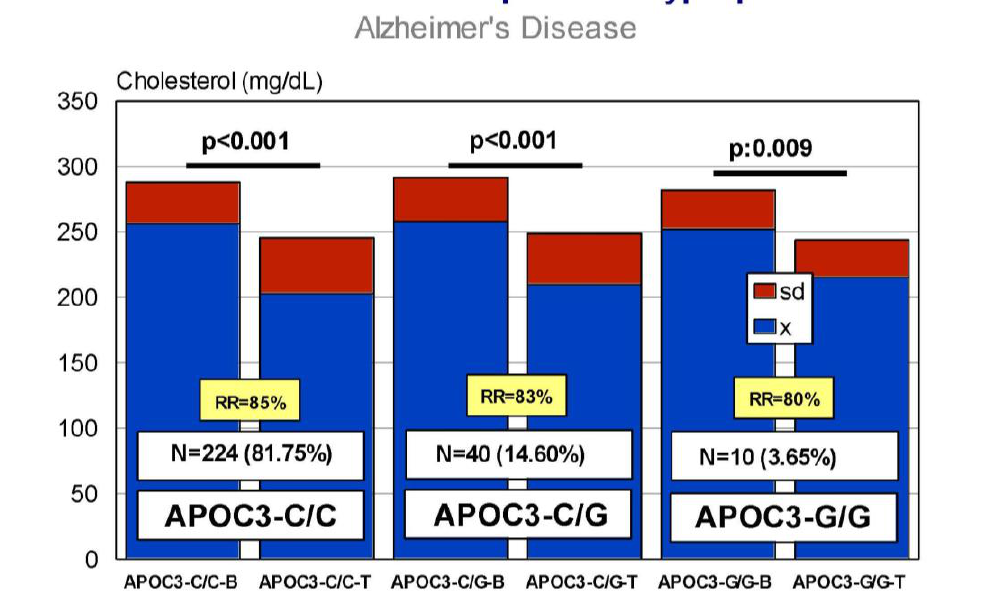
Figure 10. APOC3 -related cholesterol response to a hypolipemic treatment in hypercholesterolemic patients with Alzheimer’s disease (Atorvastatin: 10–20 mg/day; LipoEsar: 500 mg/day).